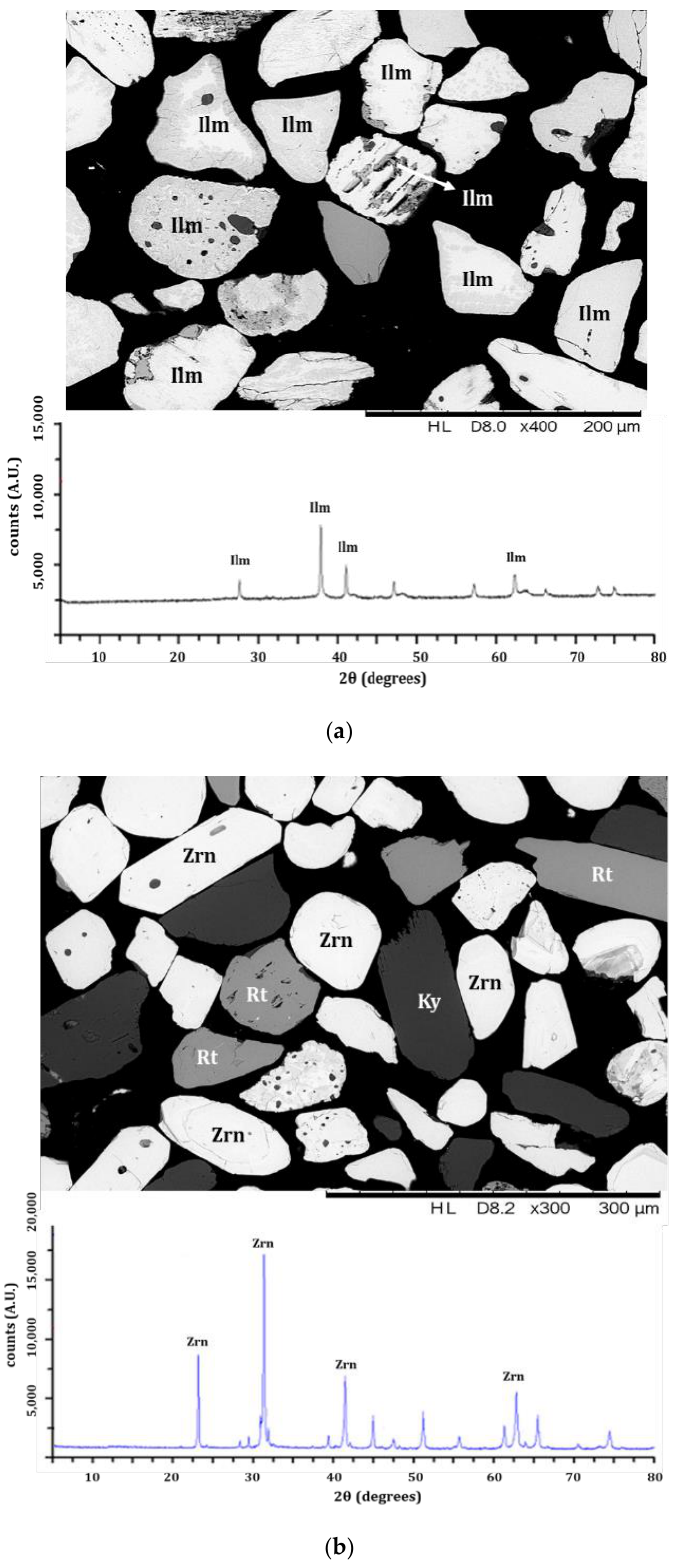
Figure 6. SEM images of LC heavy minerals retained at 0.450 T ( a ) and the nonmagnetic fraction ( b ) separated by a Frantz magnetic separator and their respective XRD spectra showing the main mineral of the fraction.